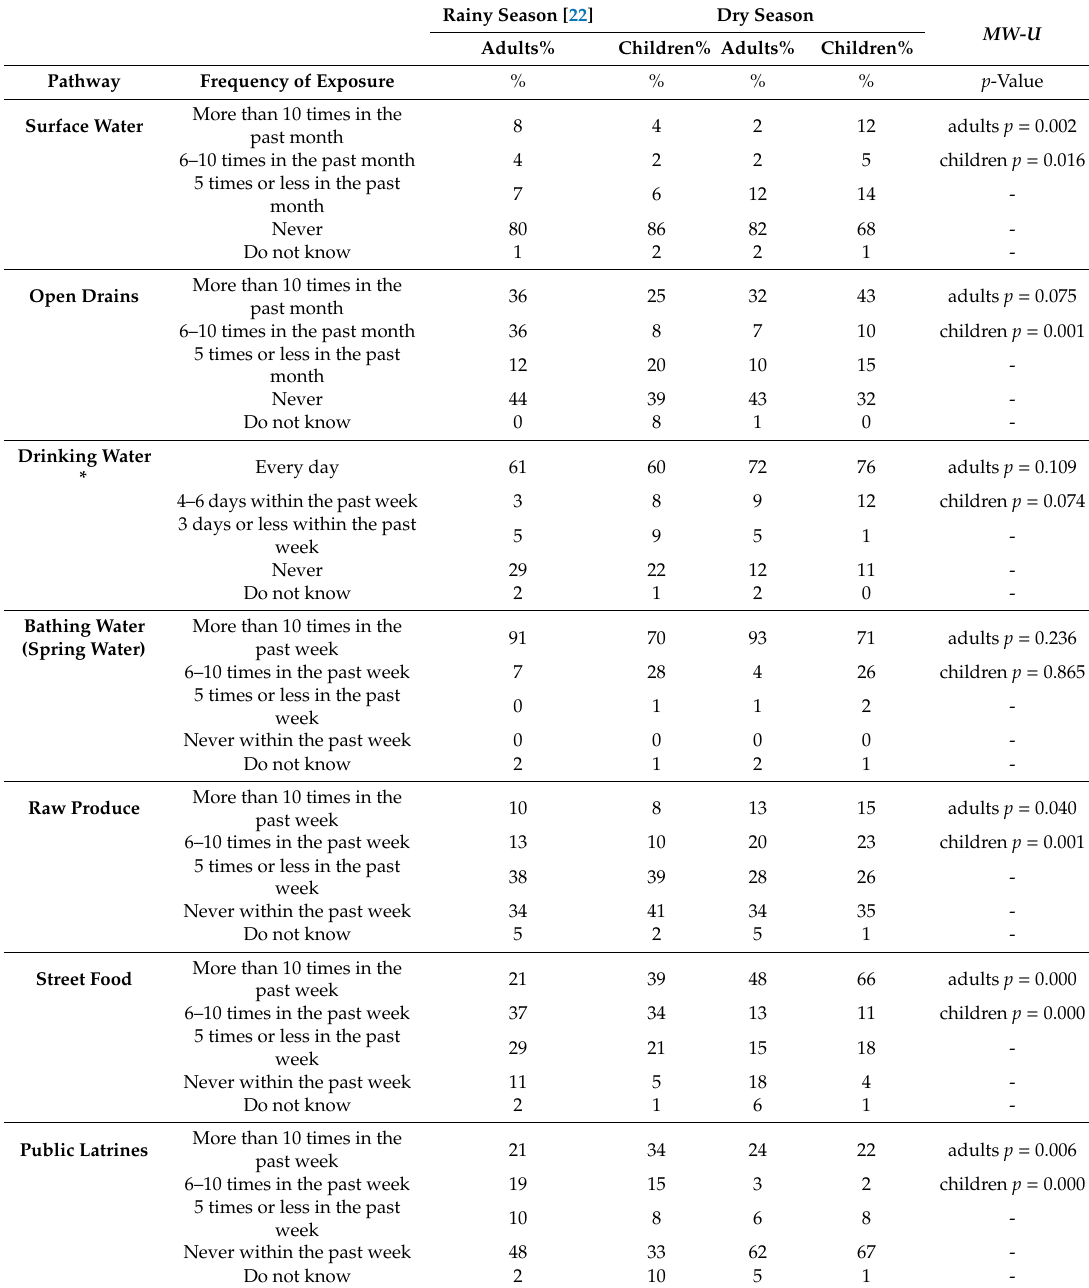
Table 3. Behavior frequency for the eight pathways for adults and children in the rainy [22] and dry seasons and the p -Values for the Mann-Whitney